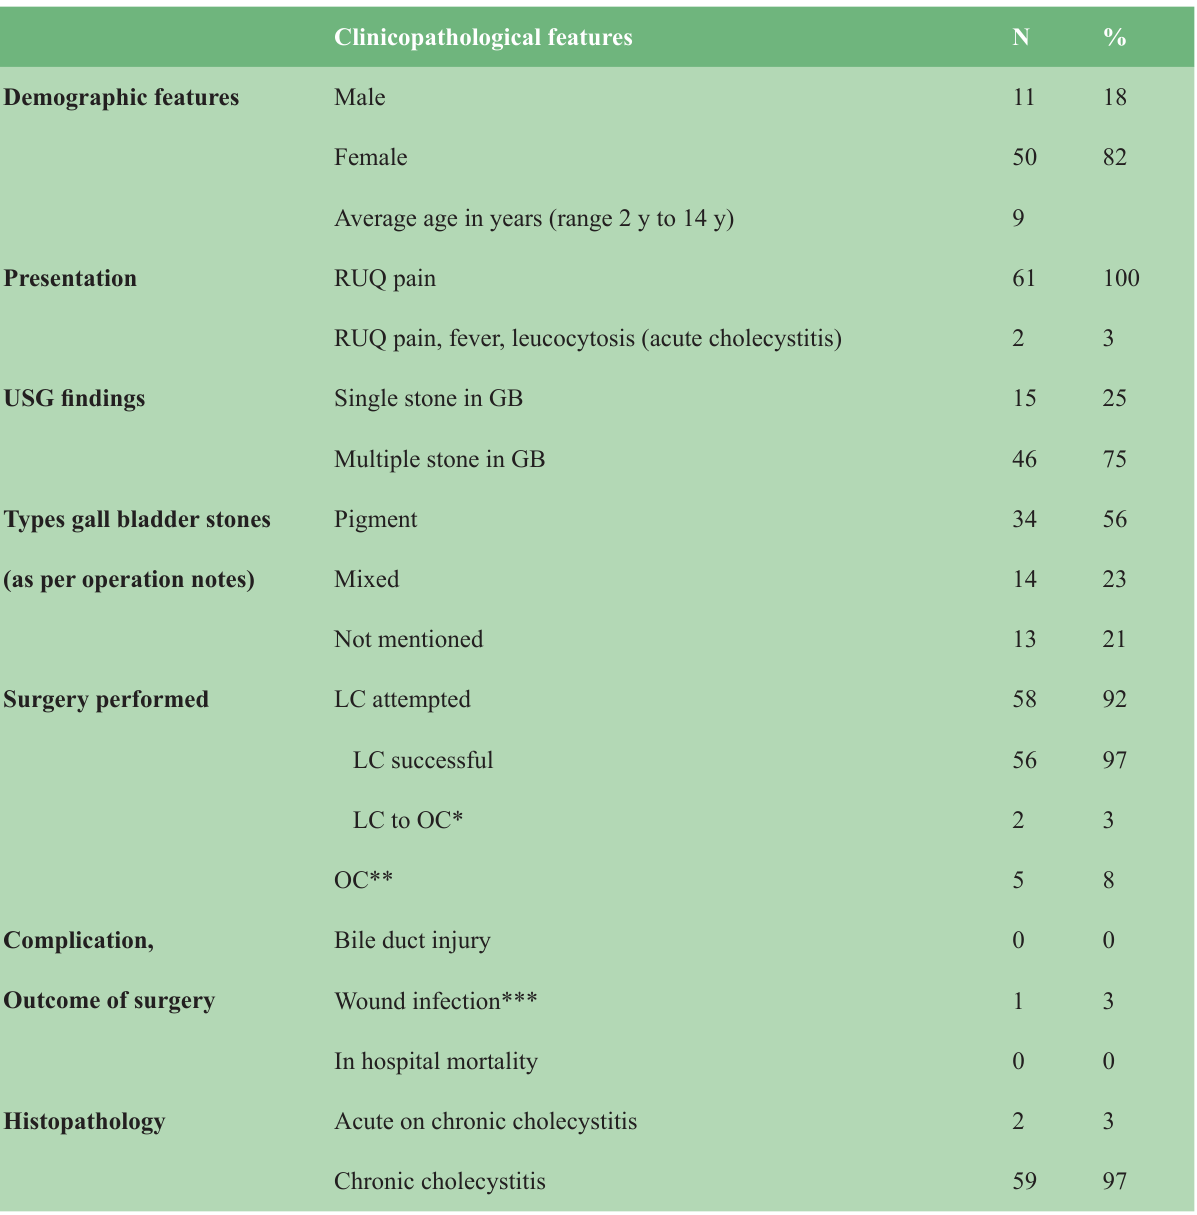
Table 3. Clinicopathological features of children (n=61) who had cholecystectomy during 2001-15 Clinicopathological